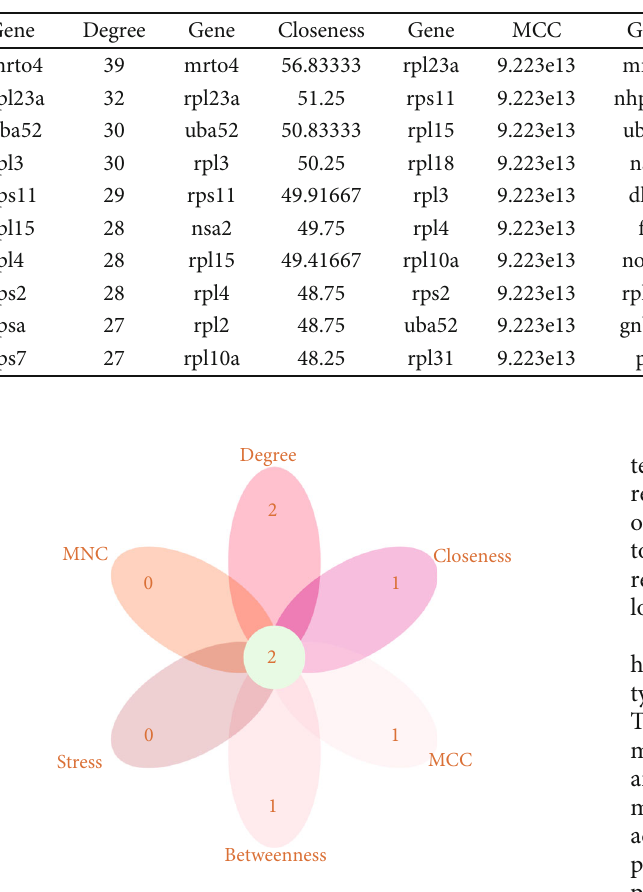
Table 4: Top 10 hub genes obtained by di ff erent algorithms.